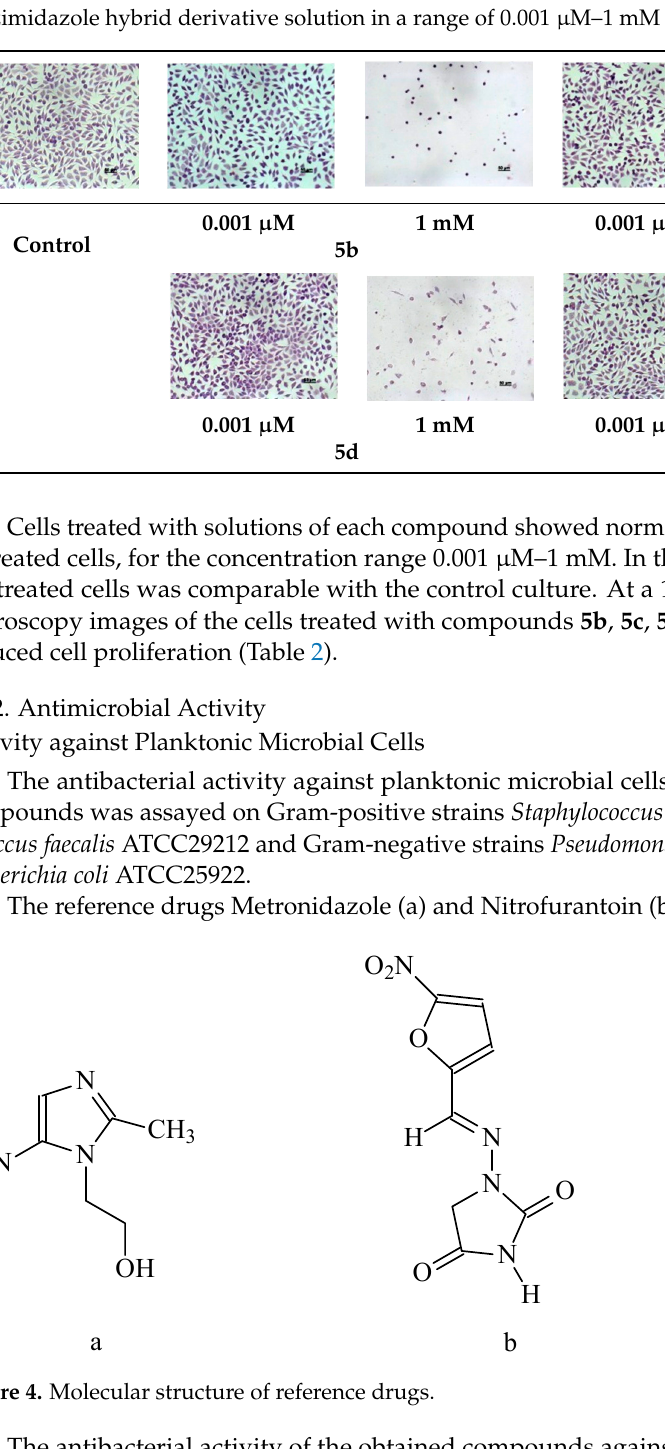
Figure 3. Cell viability of L929 fibroblasts cultured with pyrazolo-benzimidazole derivatives after 48h of experimentation, evaluated by MTT assay.